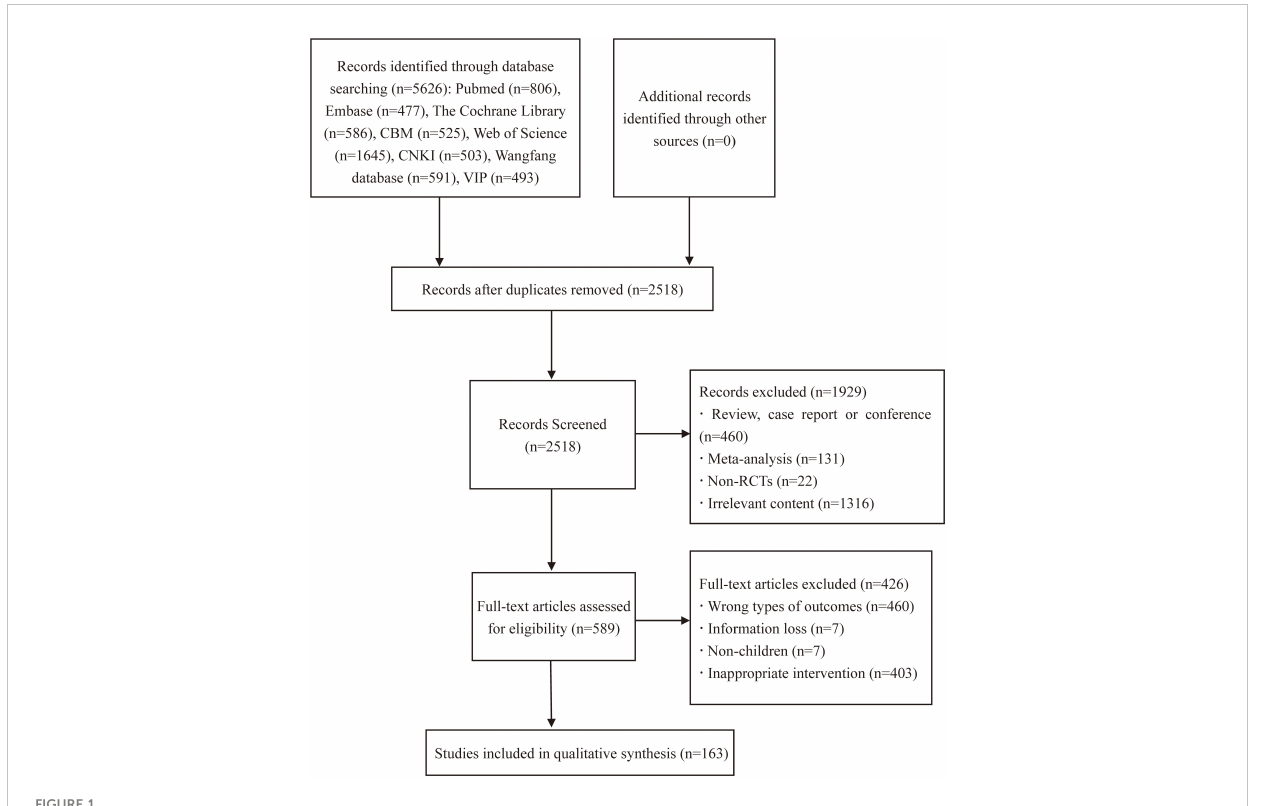
FIGURE 1 Flow diagram of the study search